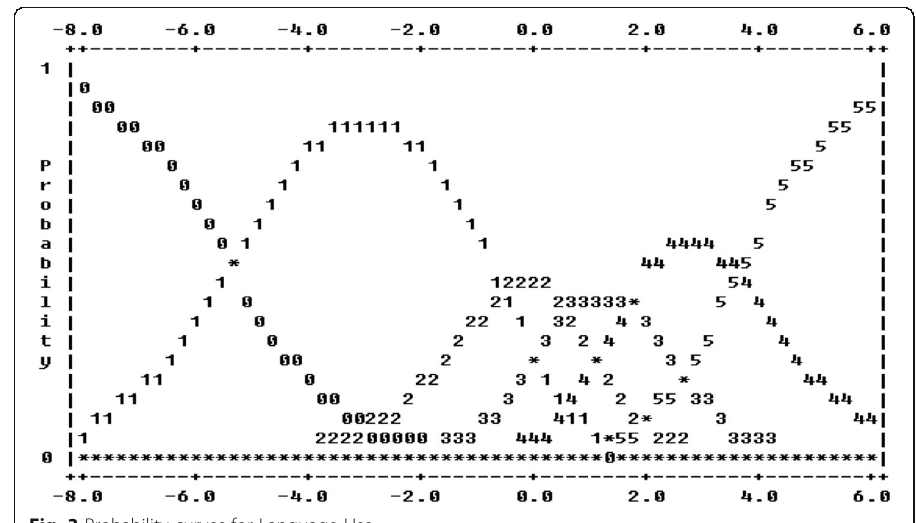
Fig. 3 Probability curves for Language Use